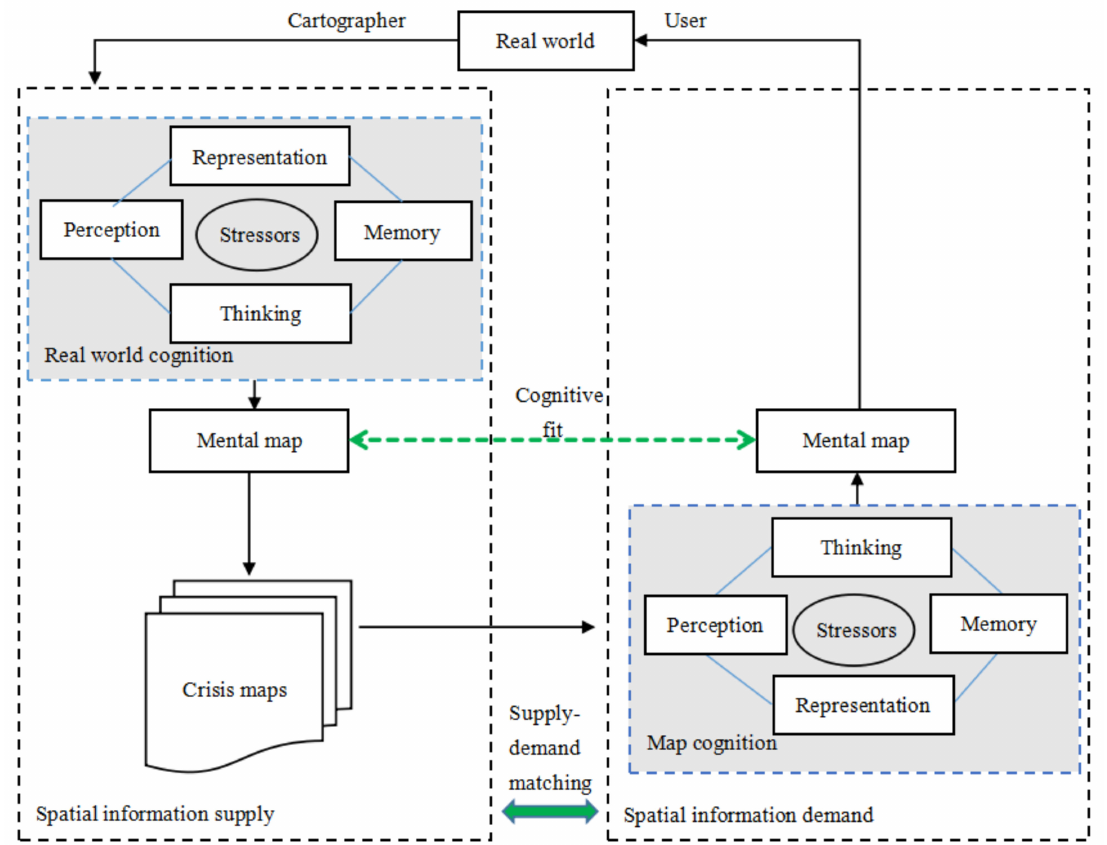
Figure 1. Cognitive fit in spatial cognition and information